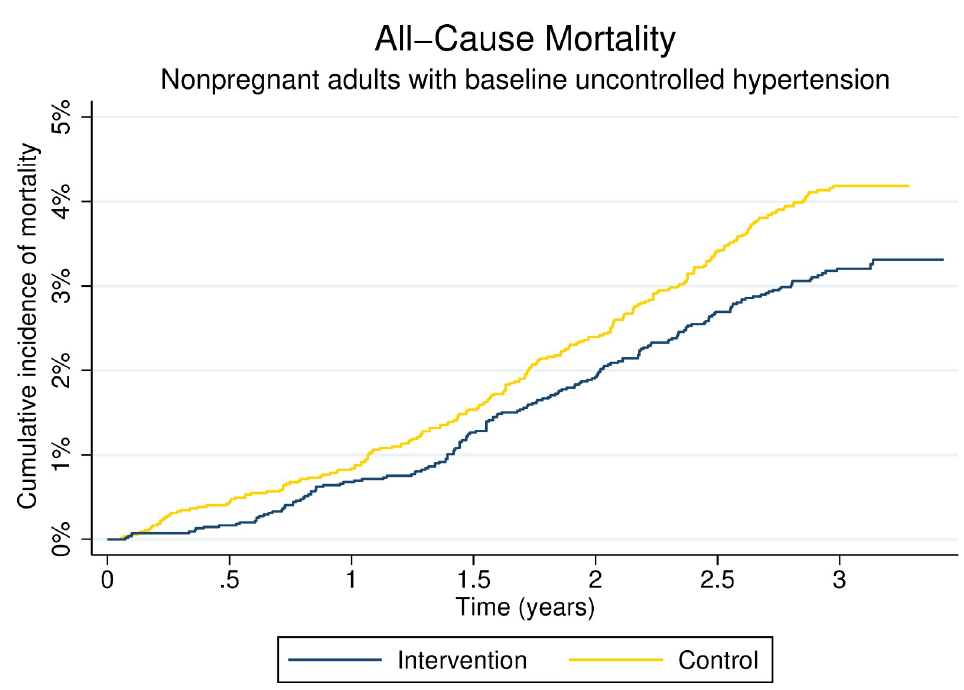
Fig 3. Kaplan–Meier curve depicting cumulative incidence of mortality by trial arm. Participants with unknown year 3 vital status were censored at the time they were last known to be alive.